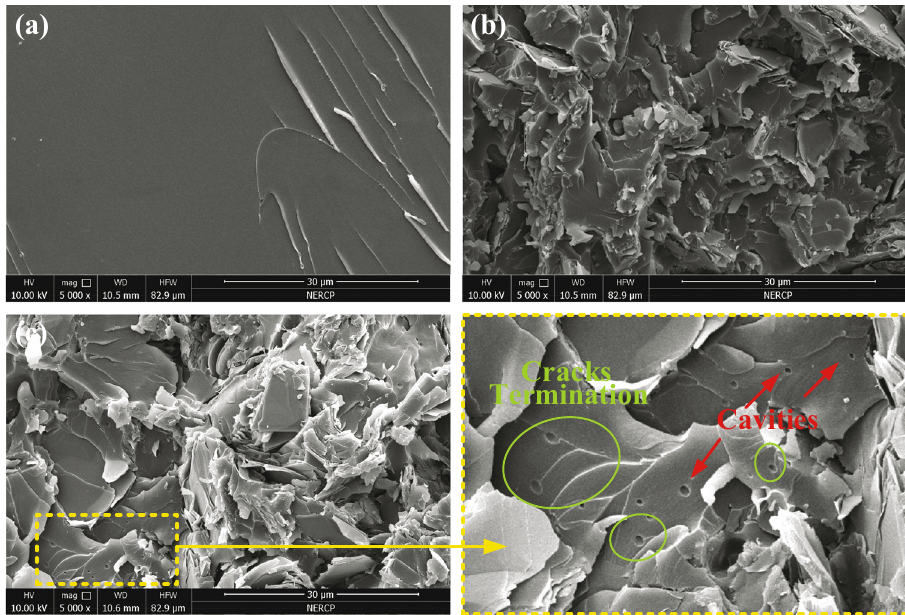
Figure 8: SEM micrographs of prepared composites. ( a ) Neat EP, ( b ) EP/h - BN ( 100:40 ) , and ( c ) EP/h - BN/EHTPB ( 100:40:20 )